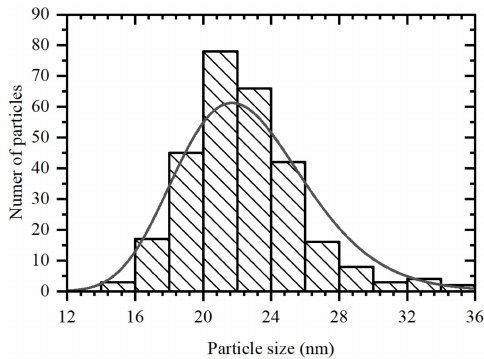
Figure 2. Particle size distribution calculated from TEM images.